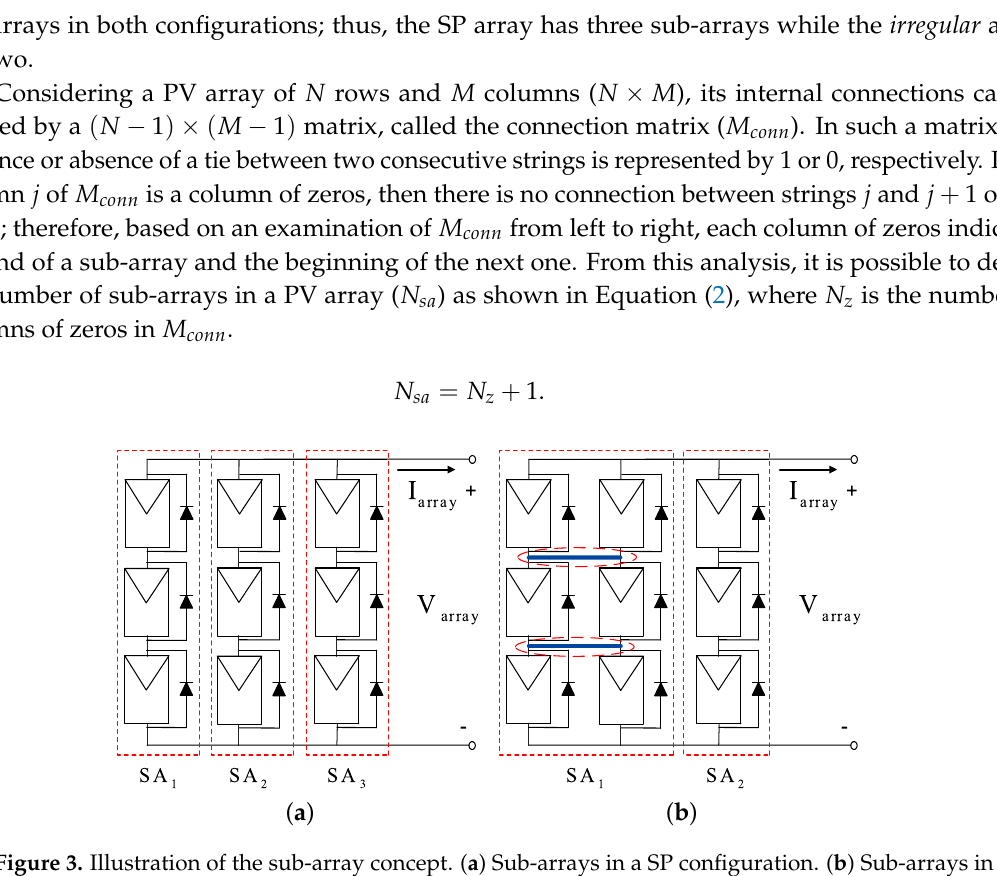
Figure 3. Illustration of the sub-array concept. ( a ) Sub-arrays in a SP configuration. ( b ) Sub-arrays in an irregular